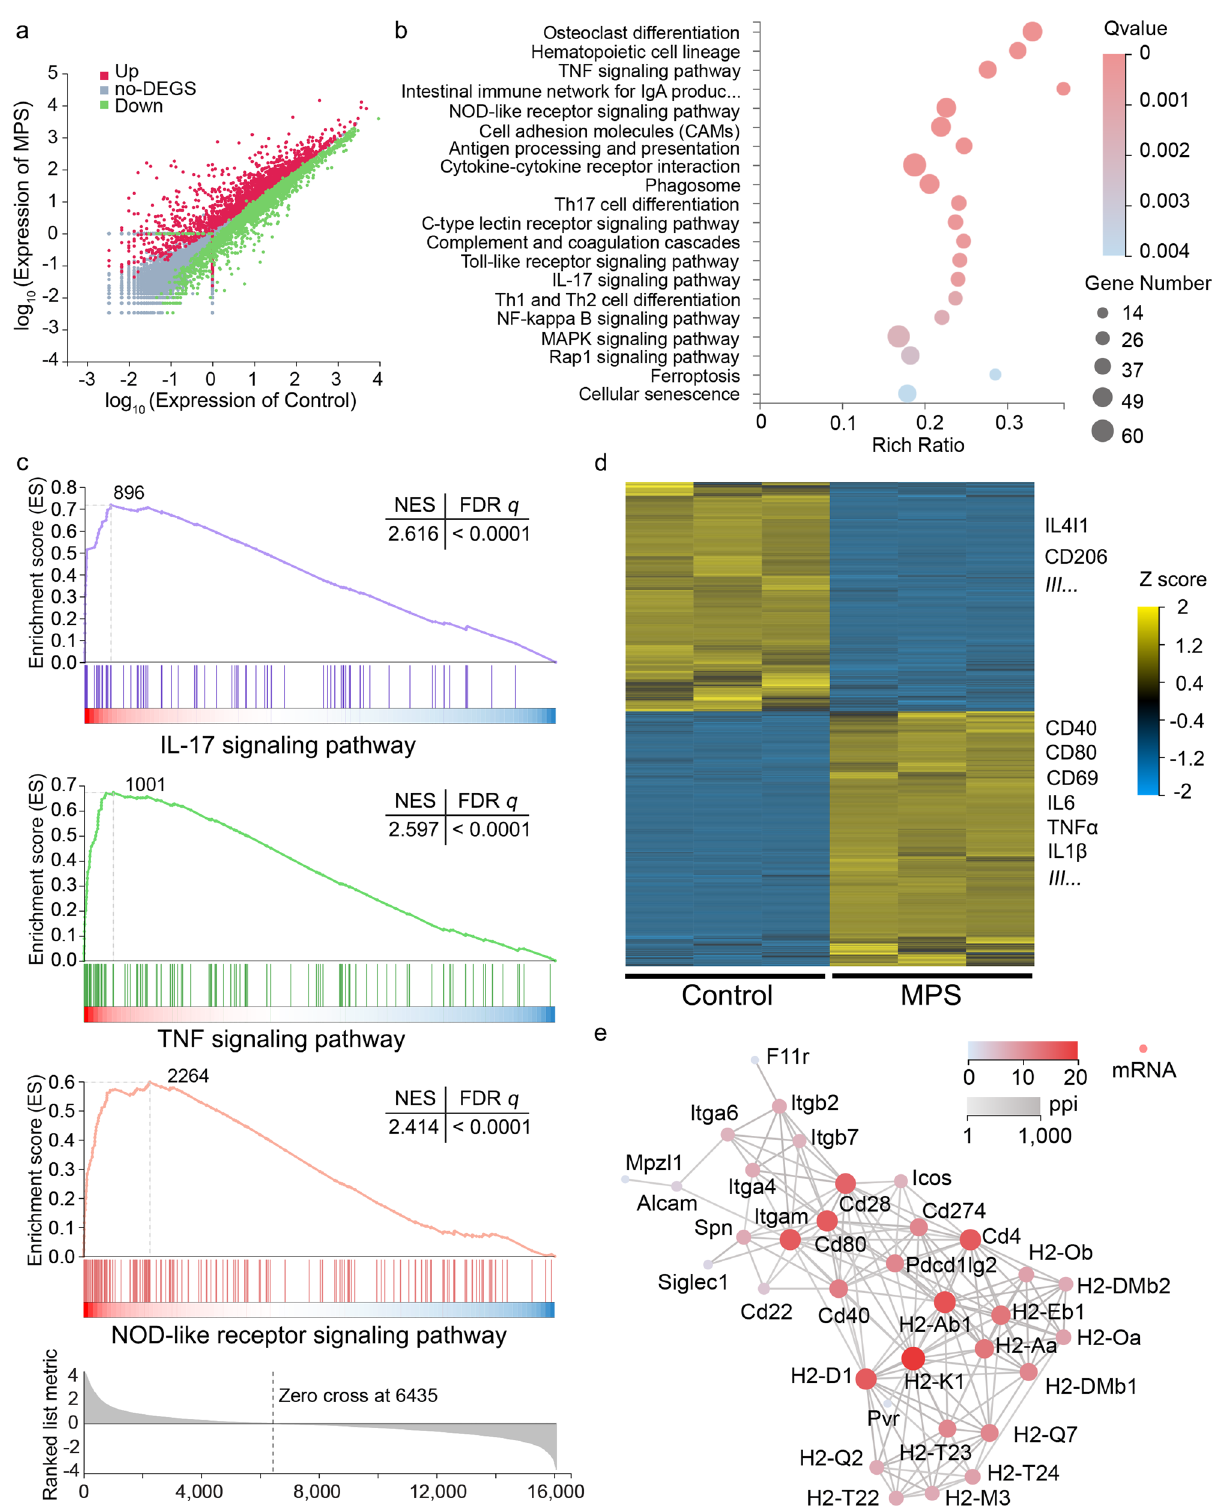
Fig.4|MPS-PVPactivatesco-stimulatorypathwaysinRAW264.7macrophages. a Volcanoplotsshowingtheexpressionlevelsofgenesindifferentgroups. b KEGG enrichment analysis reveals top 20 statistically signi fi cant (Q values <0.05) biolo- gical processes regulated by MPS-PVP. c Gene set enrichment analysis (GSEA) of representative immune signaling pathways in macrophages after MPS-PVP treat- ment. The ticks below the line represent the rank of each gene. NES, normalized